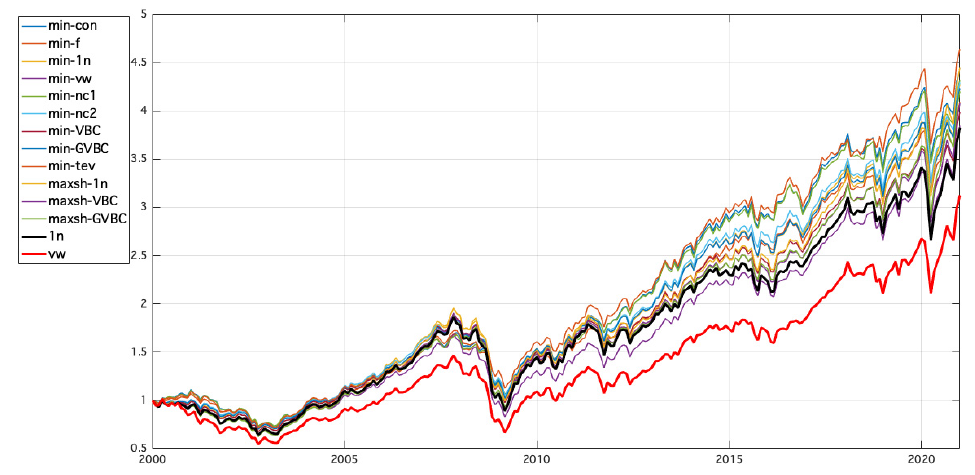
Figure 2. Cumulative returns of portfolios.